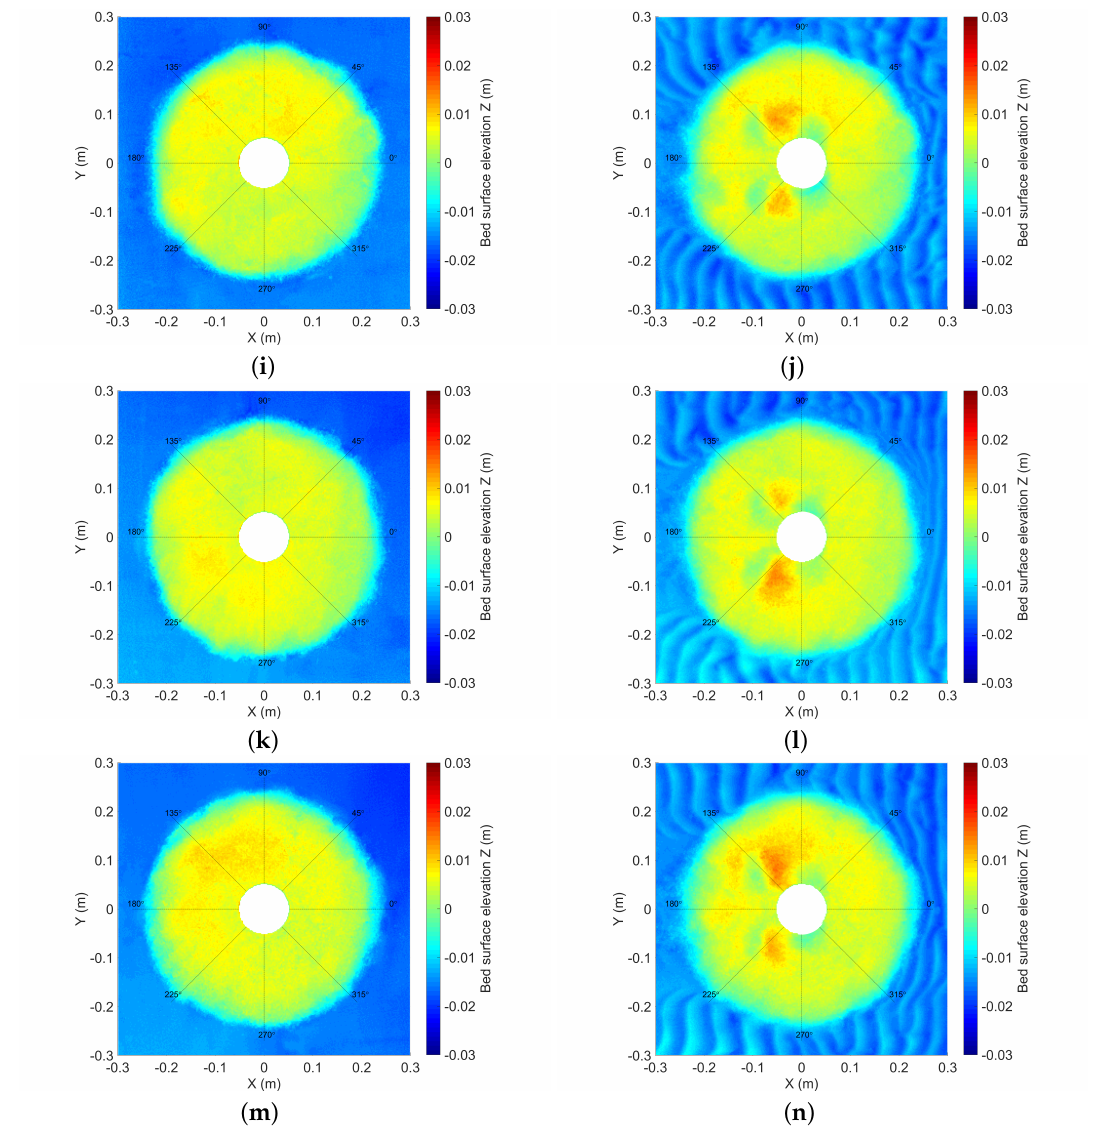
Figure 11. Initial and end profiles of TG1: ( a ) TG1_1 initial profile; ( b ) TG1_1 end profile; ( c ) TG1_2 initial profile; ( d ) TG1_2 end profile; ( e ) TG1_3 initial profile; ( f ) TG1_3 end profile; ( g ) TG1_4 initial profile; ( h ) TG1_4 end profile; ( i ) TG1_5 initial profile; ( j ) TG1_5 end profile; ( k ) TG1_6 initial profile; ( l ) TG1_6 end profile; ( m ) TG1_7 initial profile; ( n ) TG1_7 end profile. The Cartesian system presented in Figure 9 is